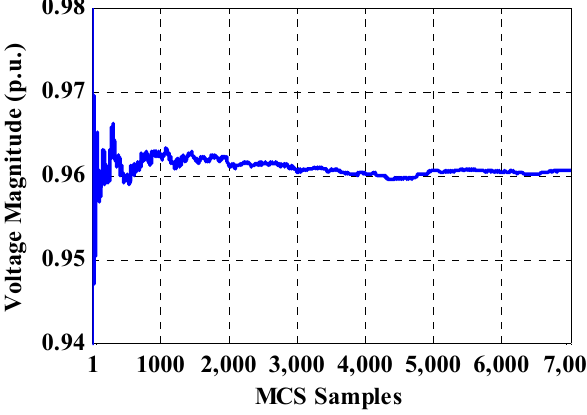
Figure 7. Convergence process of bus-33 for unsorted data-based Monte Carlo Simulation (MCS).